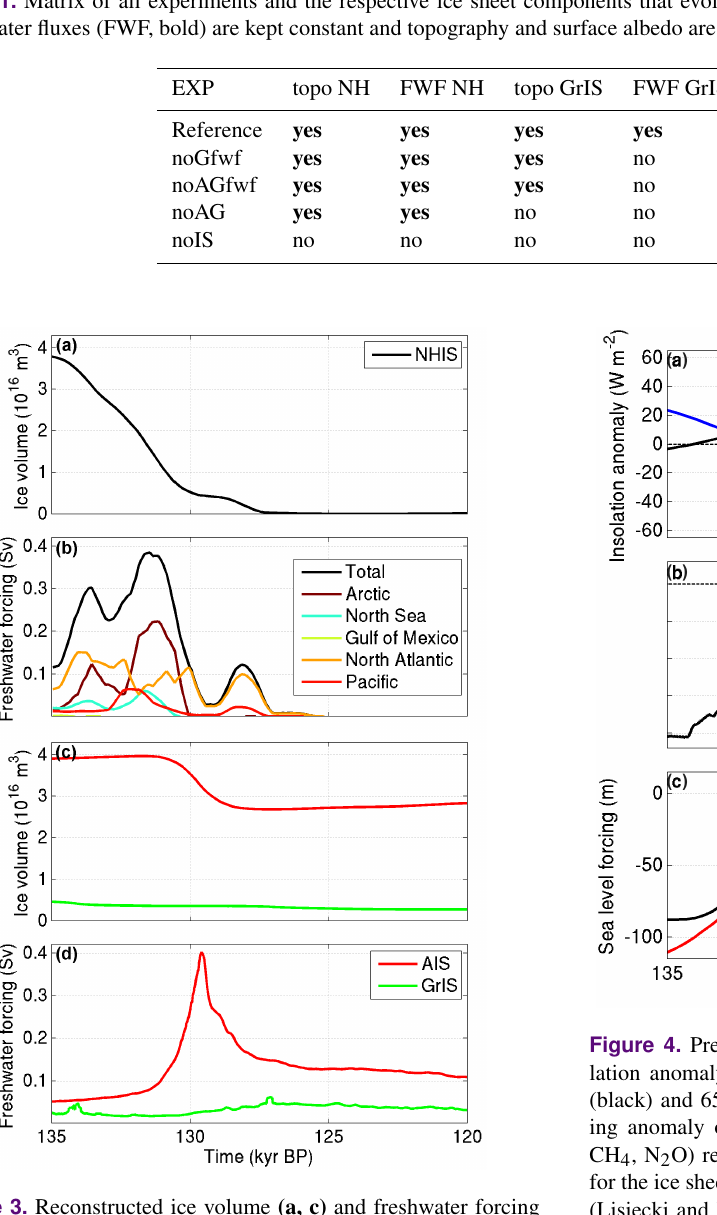
AIS and GrIS and evolving NH boundary conditions (noAG), GHG changes only with all ice sheet boundary conditions fixed (noIS). The last two experiments correspond to the allLR and IGonly experiments from Loutre et al.